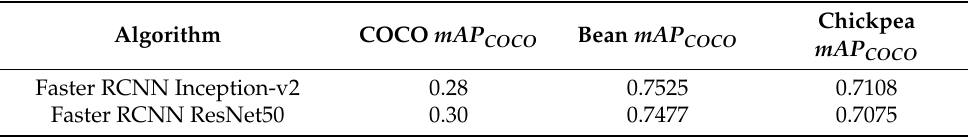
Table 1. mAP COCO values for the COCO dataset and mAP COCO for the mung bean and chick- pea